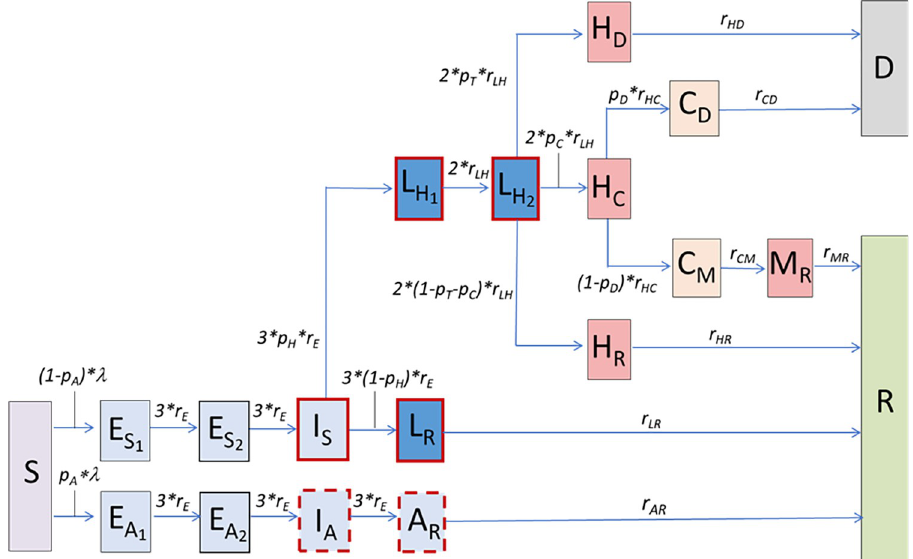
Fig 1. Schematic representation of the EpiBeds model. The construction of the compartmental model was informed by available data. EpiBeds is implemented as a set of ordinary differential equations (ODEs), with one state variable per compartment representing the absolute number of individuals in it. Arrows describe flow between compartments, which occurs at constant rate. Blue compartments indicate infected individuals who are not hospitalised, with a dark and light blue distinction, respectively, for individuals with and without symptoms, while red compartments indicate hospitalised individuals and orange compartments individuals in critical care. The compartments with a red border contain infectious individuals, with a dashed border denoting an infectivity reduced to 25% of that of the other infectious compartments; once hospitalised, it is assumed individuals no longer contribute to the community epidemic. For states in which the waiting times are not exponentially distributed (e.g. Exposed) we use multiple identical compartments enabling us to approximate gamma-distributed waiting times by using Erlang distributions. All variables, rates, and probabilities are described in Tables 2 and 3. The force of infection λ depends on the numbers in the infectious compartments (Section